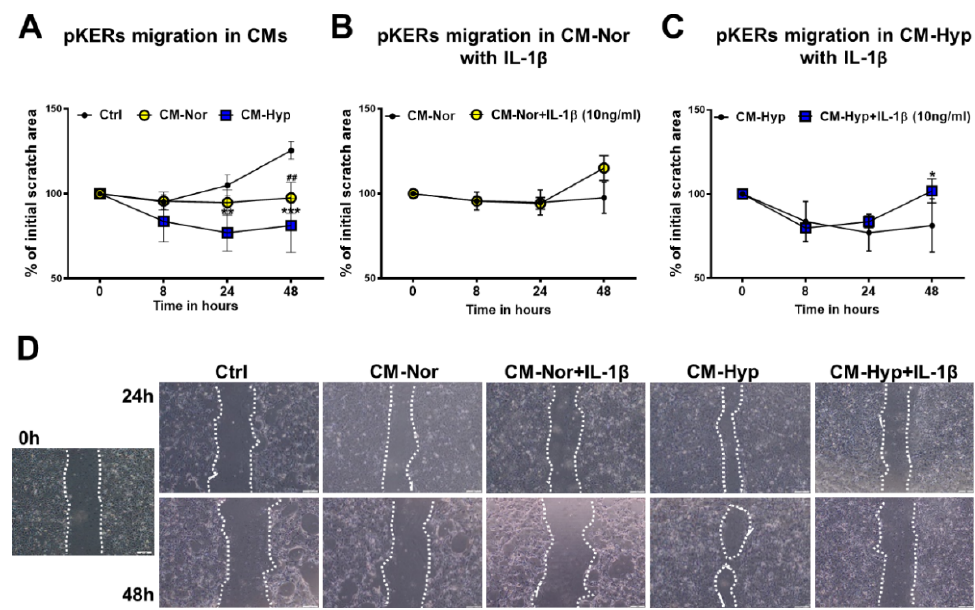
Figure 2. Effect of pASCs-CMs alone or supplemented with IL-1 β (10 ng/mL) on migratory abilities of pKERs. Wound-healing scratch assay demonstrates increased cell migration upon administration with CM-Hyp ( A ). Supplementation of CM-Nor ( B ) or CM-Hyp ( C ) with IL-1 β did not further increase pKERs motility relative to the cultures exposed to CMs alone. ( D ) Representative images depicting the stimulatory effect of CM-Hyp on pKERs movement at different time points (0, 24 and 48 h), and lack of effect of both CMs upon supplementation with IL-1 β . The results are shown as the mean ± SD. The asterisks indicate significant differences between CM-Hyp exposed cells and control cultures ( A ) or CM-Hyp vs CM-Hyp+ IL-1 β ( C ) (* p < 0.05; ** p < 0.01; *** p < 0.001). Hashes show significant differences between pKERs cultured in CM-Nor and control medium ( ## p < 0.01). Scale bars = 100 µ m ( D ). Abbreviations: pASCs, pig adipose-derived stem cell; pKERs, pig keratinocytes; CM-Nor, conditioned medium collected from pASCs exposed to normoxia; CM-Hyp, conditioned medium collected from pASCs cultured under hypoxia; IL-1β, interleukin 1 beta.